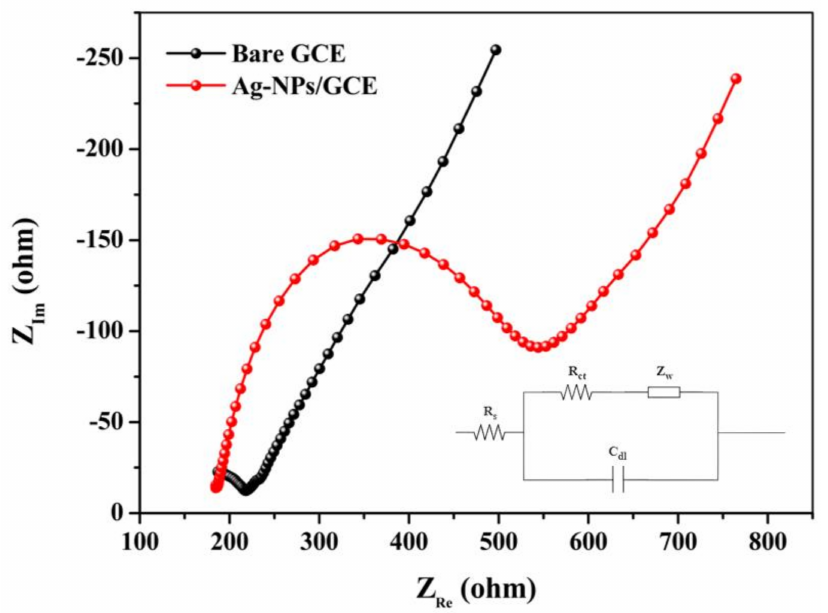
Figure 7. The Nyquist plots of bare GCE and Ag-NPs/GCE in a solution containing 5 mM [Fe(CN) 6 ] − 3/ − 4 in 0.1 M KCl with an equivalent circuit diagram